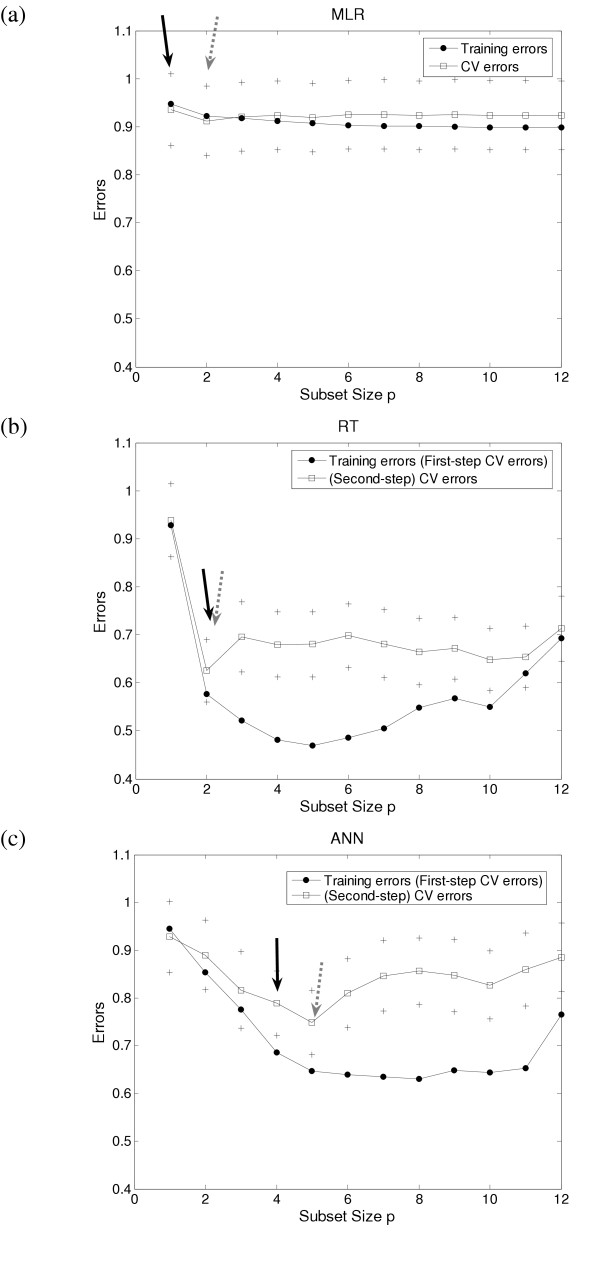
Training and cross-validation (CV) errors of the multivariate models. Minimum training errors (solid circles) of (a) multiple linear regressions (MLRs), (b) regression trees (RTs), and (c) artificial neural networks (ANNs) in the first CV training set decreased, while the CV errors [open squares; Equation (4)] reached the minimum (light-dotted arrows) at the subset size of 2 in (a), 2 in (b), and 5 in (c). The most parsimonious model (dark-solid arrows) within one standard error of the model with the minimum error was the model with 1 predictor for (a), 2 predictors for (b) and 4 predictors for (c). (The cross-validated variance of TY, for reference, is 1.43 ± 0.13).